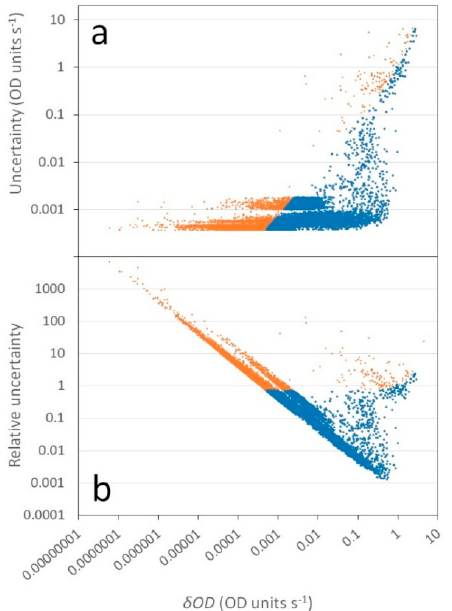
Figure 6. Dependence of absolute ( a ) and relative ( b ) uncertainties of the derived δ OD (at 500 nm) on its absolute value. Blue (orange) points correspond to cases passing (not passing) the condition in Equation (9). High relative uncertainties (above 100%) for relatively large δ OD (above 0.01 OD units s − 1 ) correspond mainly to cases of 28 April.